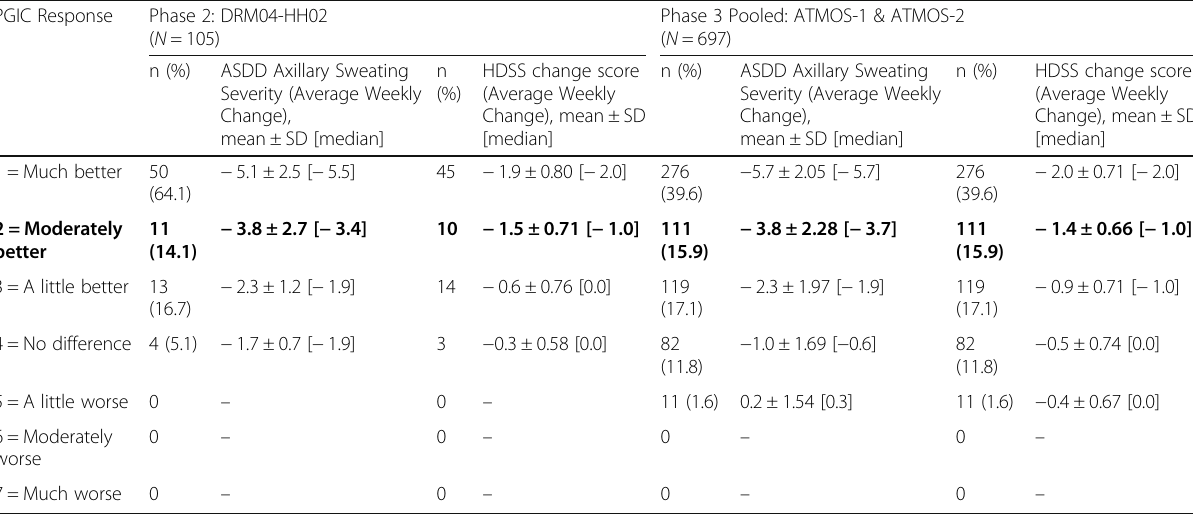
Bold text represents the preferred threshold for meaningful response consistent with FDA guidance ( “ moderately better ” ) ASDD Axillary Sweating Daily Diary, PGIC Patient Global Impression of Change, SD Standard deviation